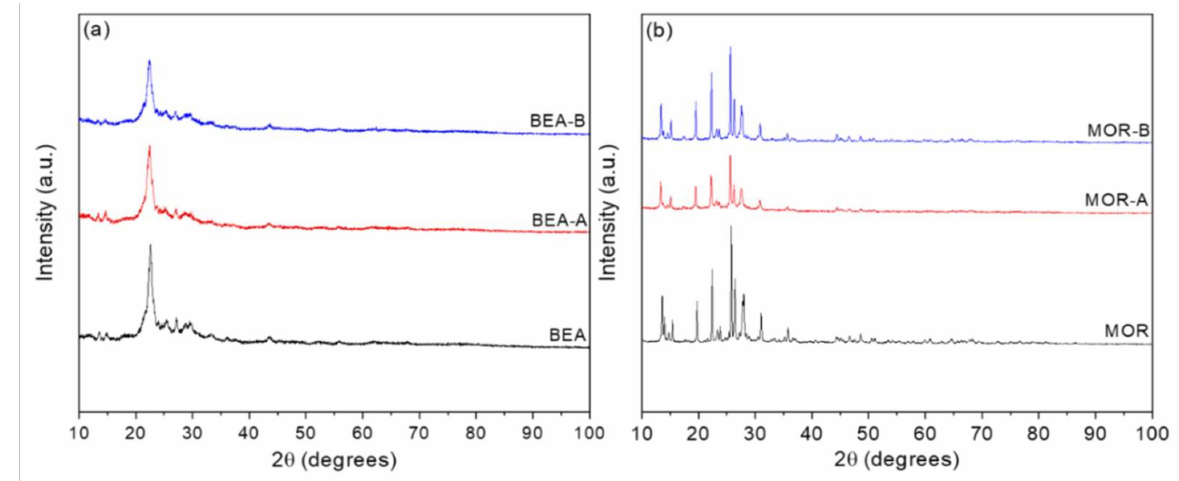
Figure 1. XRD diffractograms of the ( a ) beta and ( b ) mordenite zeolite samples.